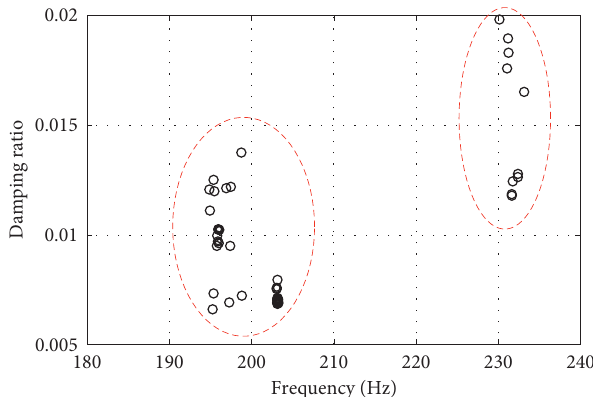
Figure 24: The distribution of identified frequency-damping with model order when using 􏽥 h ( k ) by IFFTof S ( ω ) , for damage case